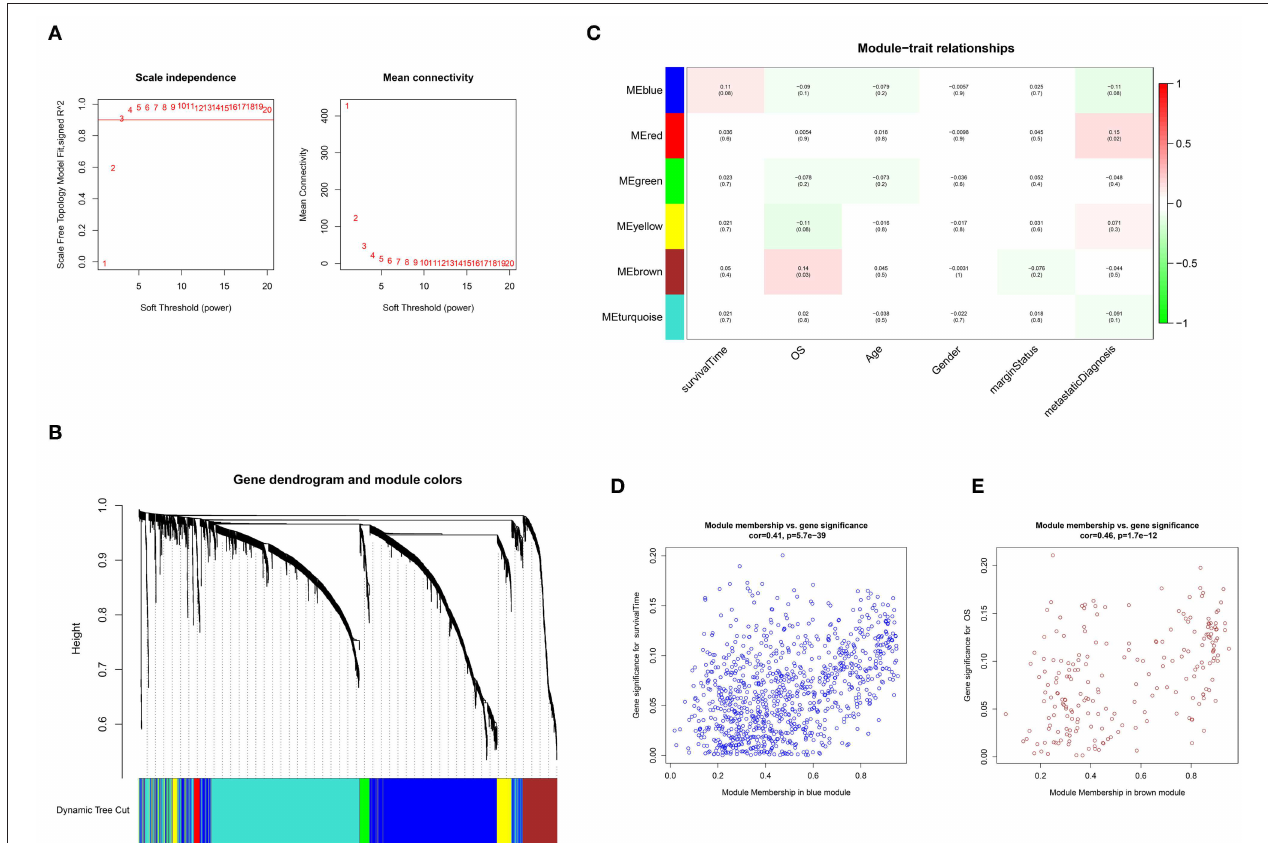
FIGURE 1 | Weighted gene co-expression network analysis (WGCNA). (A) Selection of the optimal soft threshold power, β (optimal β = 3, scale free topology index, R 2 = 0 · 9). (B) Module identification using the Dynamic Tree Cut method. The different color bands provide a simple visual comparison of module assignments. (C) Module–trait relationship. Six modules were identified and related to clinical traits. Each cell represented the correlation (and p -value) of the module with the corresponding clinical trait. OS represented the overall survival status (alive or dead). (D) Identification of genes with high significance and module membership in the survival time-related blue module. (E) Identification of genes with high significance and module membership in the OS-related brown module.